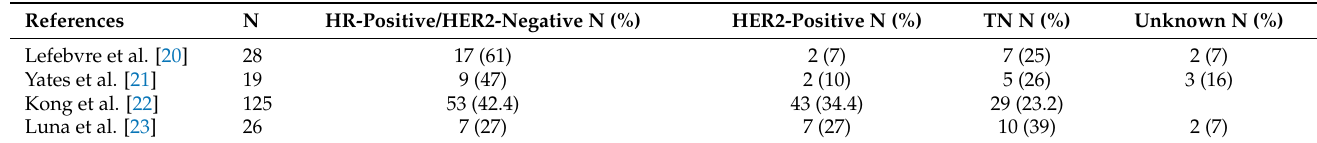
Table 1. Distribution of molecular phenotypes in the cases of BC with MC of each